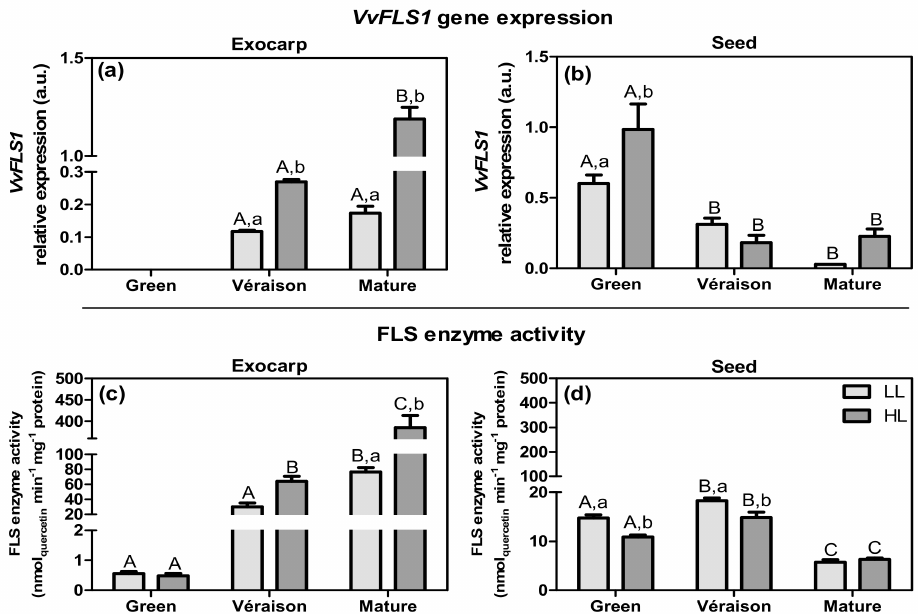
Figure 6. Relative expression in arbitrary units (a.u.) of transcripts of flavanol synthase 1 gene ( VvFLS1 ) in ( a ) exocarp and ( b ) seeds, from berries grown at two distinct light microclimates (LL and HL) and at three developmental stages (green, v é raison , and mature), as determined by real-time qPCR. Expression levels are normalized to the mean expression of reference genes VvACT1 and VvGAPDH . Statistical analysis (two-way ANOVA, p ≤ 0.05, n = 3) was applied after data Log(X+1) transformation. Flavonol synthase (FLS) biochemical activity (expressed in V max (nmol quercetin min − 1 mg − 1 protein)) in ( c ) exocarp and ( d ) seeds, from berries grown at two distinct light microclimates (LL and HL) and at three developmental stages (green, v é raison , and mature). Statistical analysis (two-way ANOVA, p ≤ 0.05, n = 5) was applied. Statistical notation: capital letters refer to differences between developmental stages for the same microclimate, and lowercase letters refer to differences between microclimates for each stage. When the letters are omitted, it means that the respective factor did not have a significant